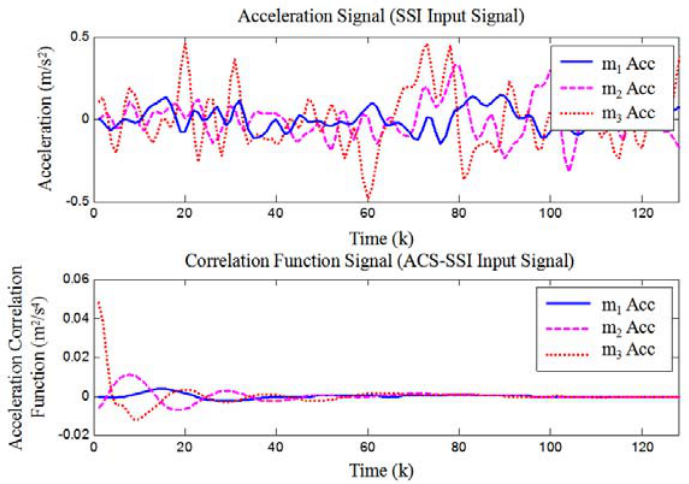
Figure 2. Input signal of stochastic subspace identification (SSI) and average correlation signal based stochastic subspace identification (ACS-SSI). m 1–3 = mass blocks. Acc: Acceleration Correlation.